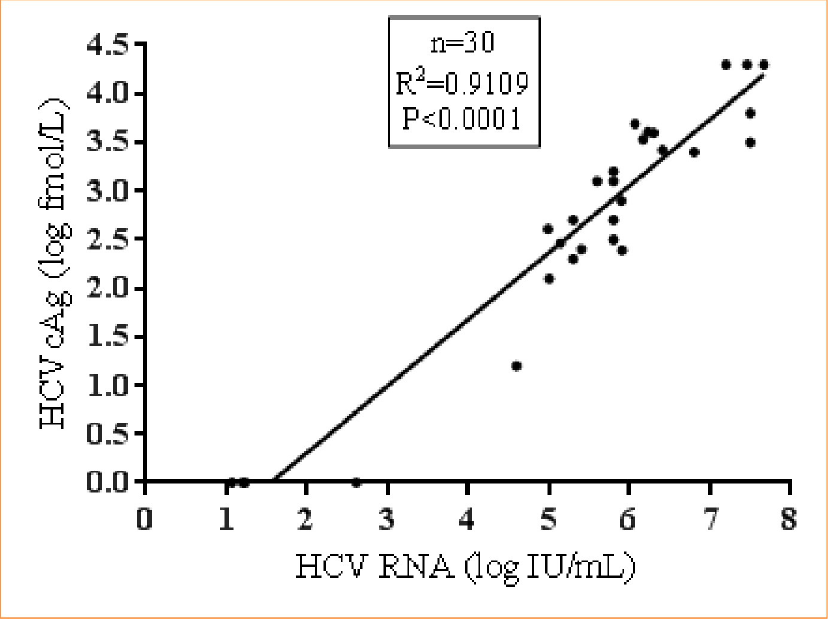
Fig 6. Correlation between HCV RNA and HCVcAg in HCV RNA positive with anti-HCV negative